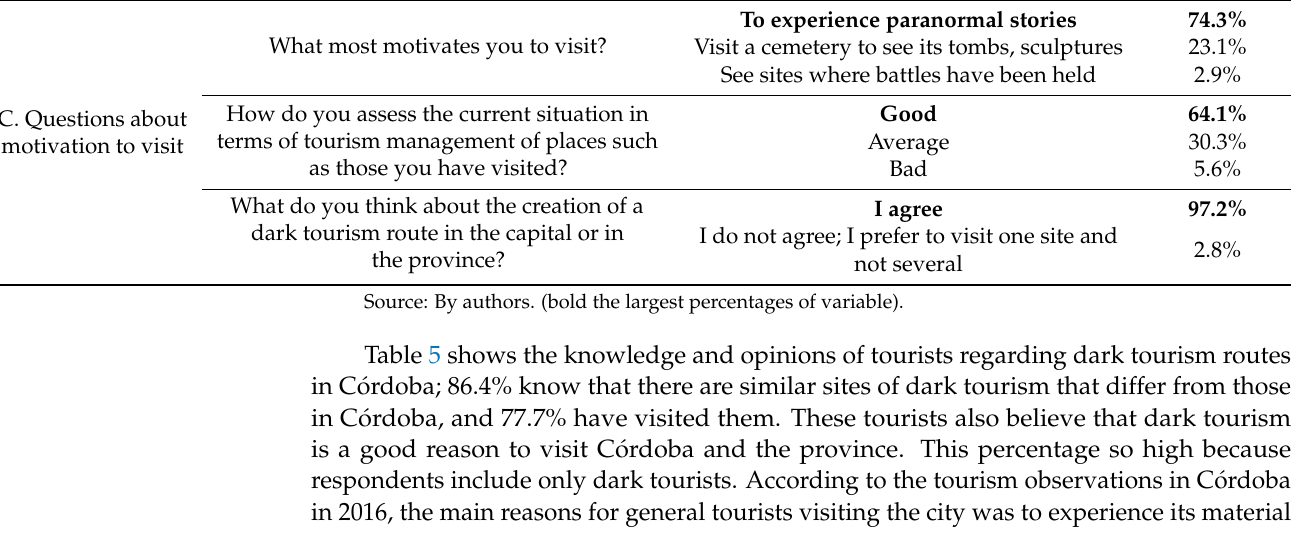
Table 4. Univariate results of a survey of people who carried out dark tourism in C ó rdoba: Motivations. Block